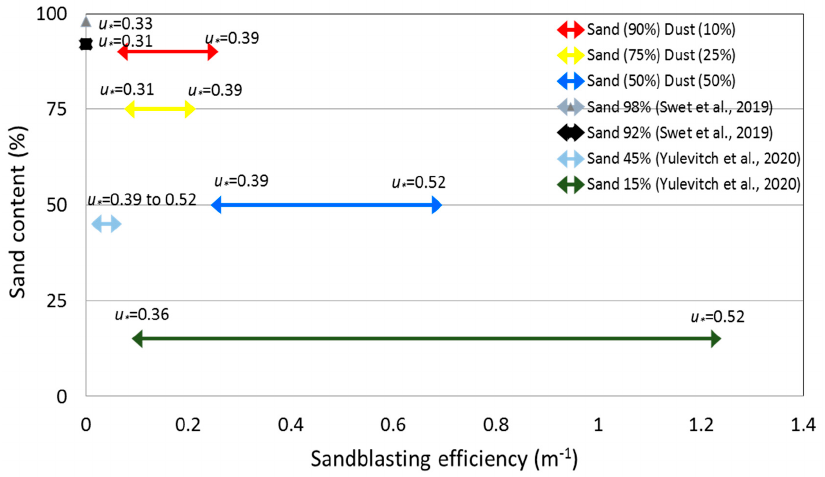
Figure 6. Sandblasting efficiency calculated for soils with different content of sand under a range of wind velocities. In addition, the chart shows the sandblasting efficiency of previously published studies of samples with different sand content [15,16].